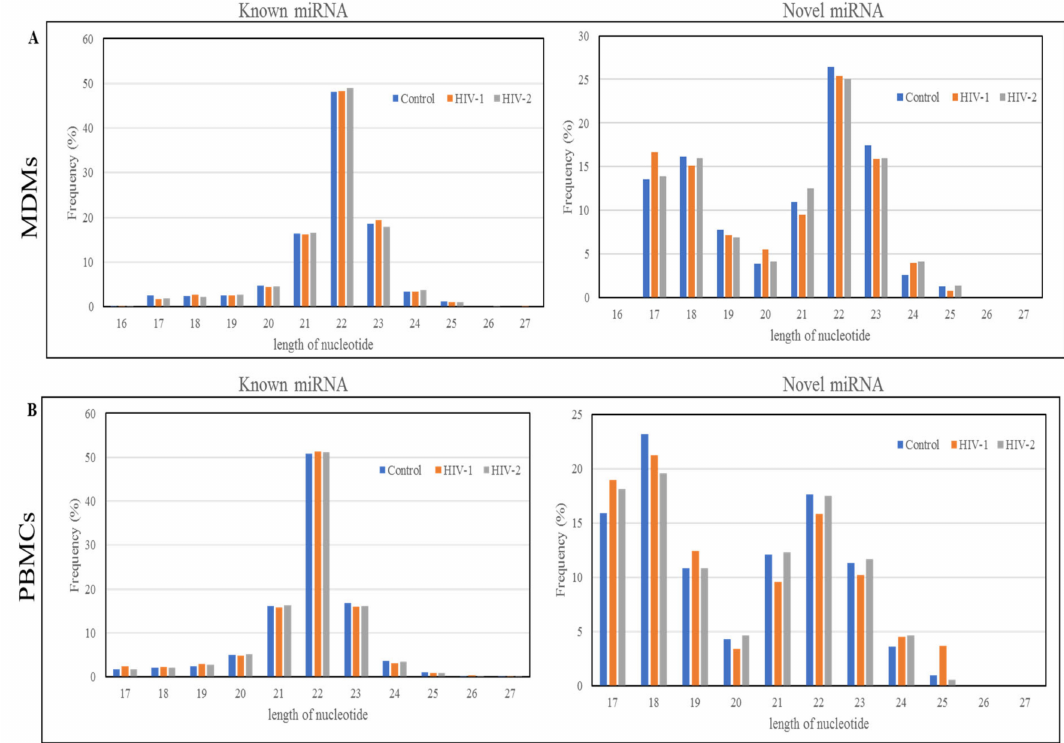
Figure 2. The length distribution and frequency of all the mapped miRNAs in MDMs ( A ) and PBMCs ( B